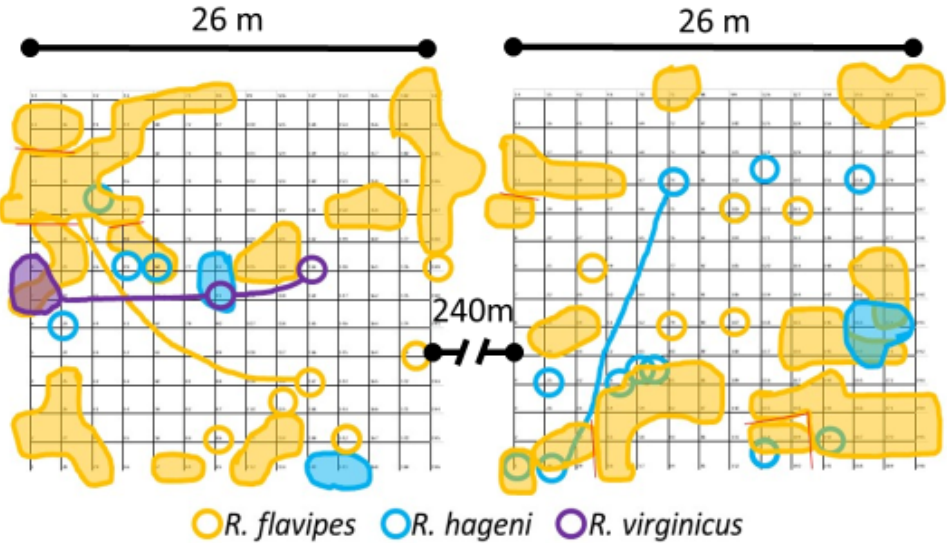
Figure 1. Cumulative locations and foraging areas of Reticulitermes colonies for the first six months of sampling. Samples were collected monthly. Shaded shapes indicate colony range, empty circles indicate single occurrence of colony, lines link samples distantly connected.